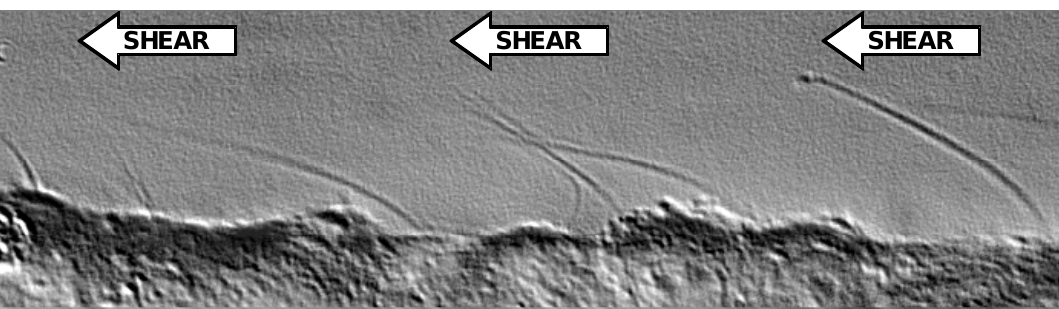
Figure 2. Cilia are sensory organelles that sense fluid-shear stress on the apical membrane of the cells. Fluid flow that produces enough drag-force on the top of the cells will bend sensory cilia. This biomechanical properties play a very important role in vestibular organs that support bodily fluid